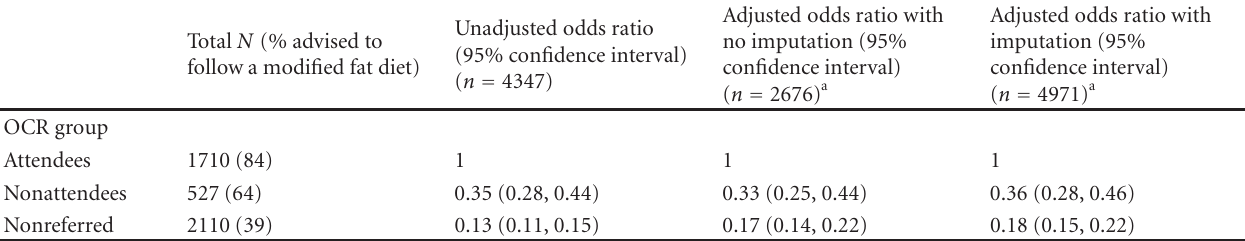
Complete case analysis. b Multiple imputation